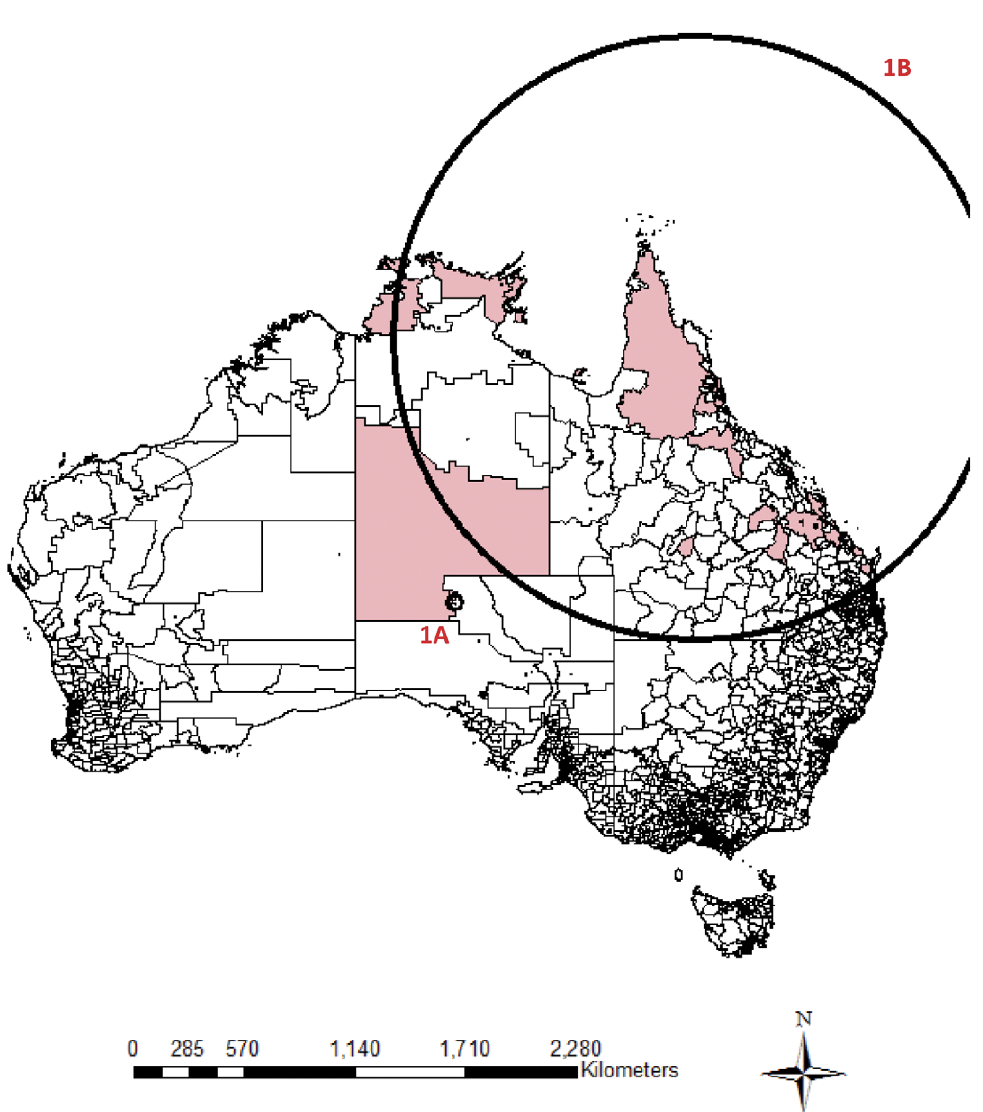
Figure 1. Significant clusters identified by national cluster detection with 1 month maximum temporal cluster size. Remark: Shaded regions are postal areas with completed suicide incidents within the particular clustering period. Circles represent the significant clustering windows detected by scan statistics. ( Figure 5 ). New South Wales, Victoria, Queensland and South Australia had similar ranges (11.1 to 14.7). South Australia and Tasmania have relatively lower ranges, which were 10.5 to 13.2